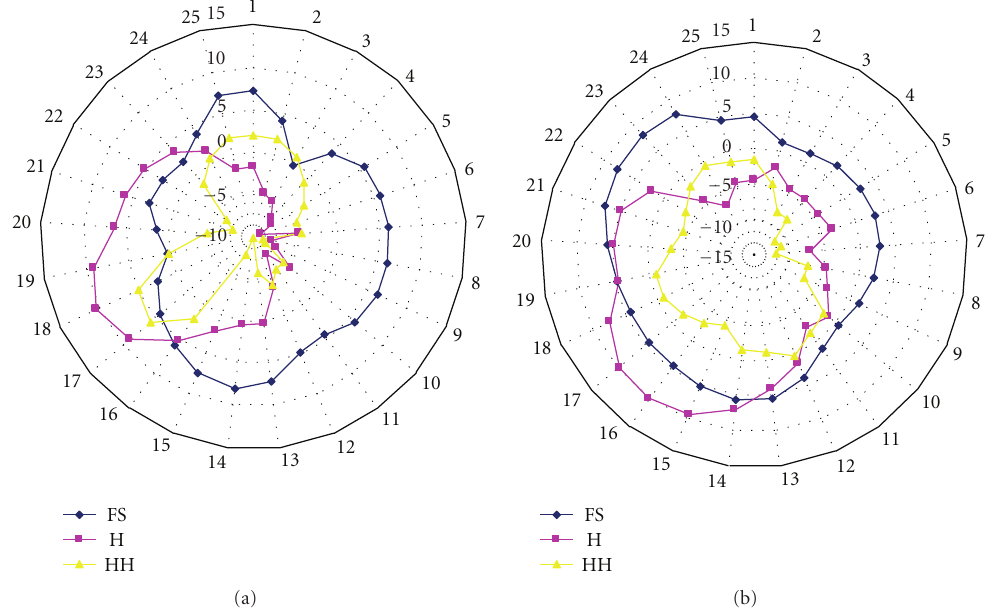
Figure 7: Measured radiation patterns (in dBm) on the azimuth plane ( x - y ) for (a) antenna 1 and (b) antenna 2—FS: free space, H: voice scenario with only head, HH: voice scenario with head and hand.